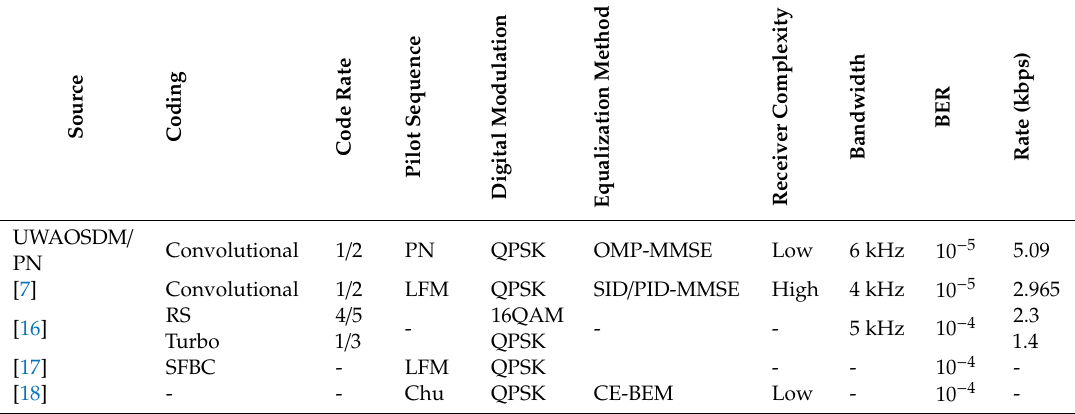
Table 3. Comparison of the UWAOSDM / PN and the other underwater acoustic (UWA) OSDM